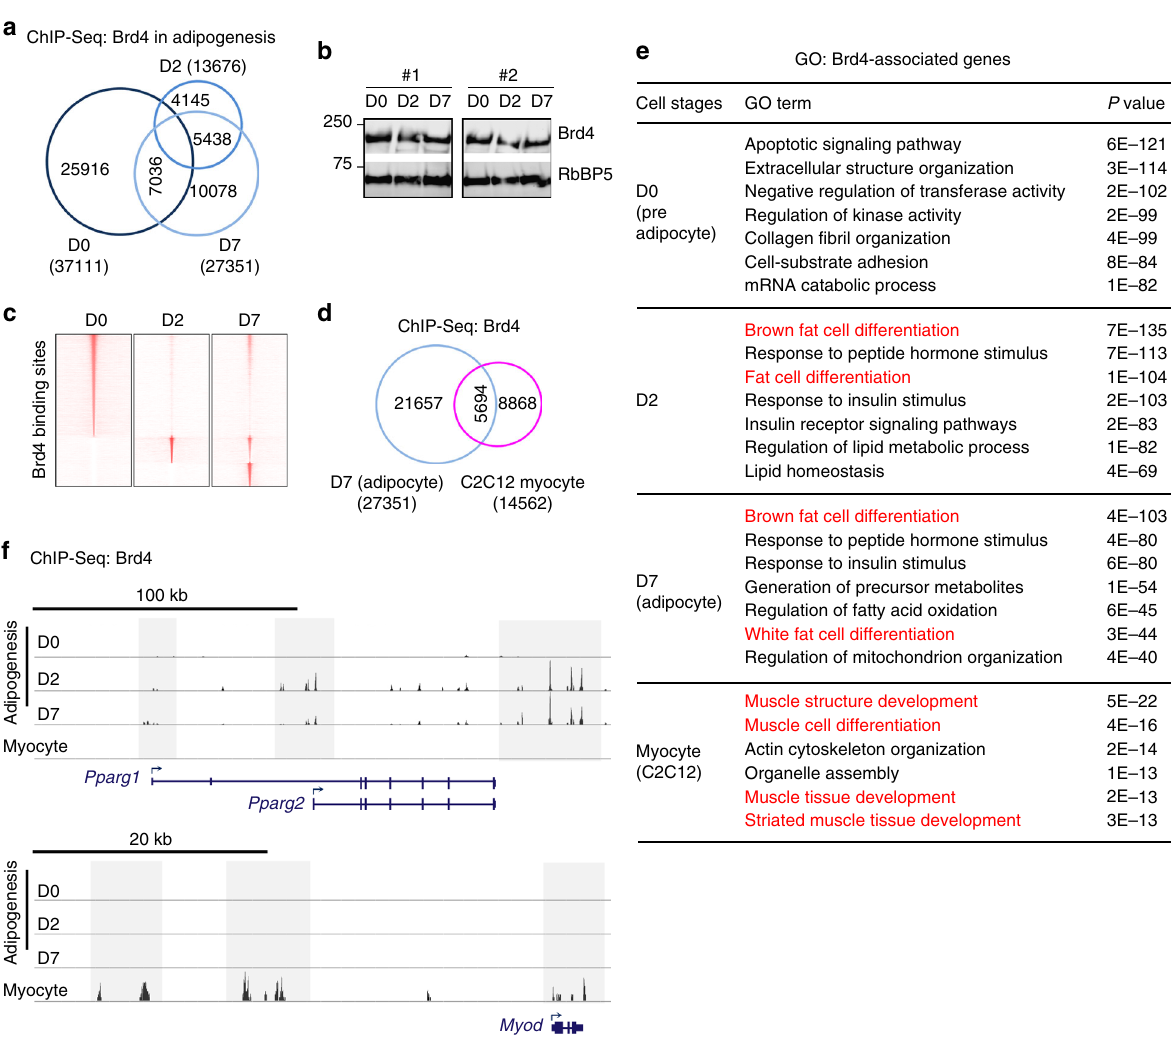
Fig. 3 Cell-type- and differentiation-stage-speci fi c binding of Brd4 on cell identity genes. Adipogenesis and myogenesis were done as in Fig. 2 and Supplementary Fig. 4, respectively. Cells were collected for ChIP-Seq analysis of Brd4. a Venn diagram depicting high-con fi dence Brd4 binding regions at D0 (preadipocytes), D2 (during adipogenesis), and D7 (adipocytes) of adipogenesis. High-con fi dence Brd4 binding regions were obtained by selecting overlapping regions from two biological replicates. b Western blot analysis of Brd4 during adipogenesis using nuclear extracts prepared from two independent brown preadipocyte cell lines. c Heat maps of Brd4 binding sites during adipogenesis. d Venn diagram representing Brd4 binding regions in adipocytes and myocytes. e GO analysis of genes associated with Brd4 binding regions at indicated time points and cell types. f ChIP-Seq pro fi les of Brd4 binding on gene loci encoding PPAR γ and MyoD at indicated time points and cell